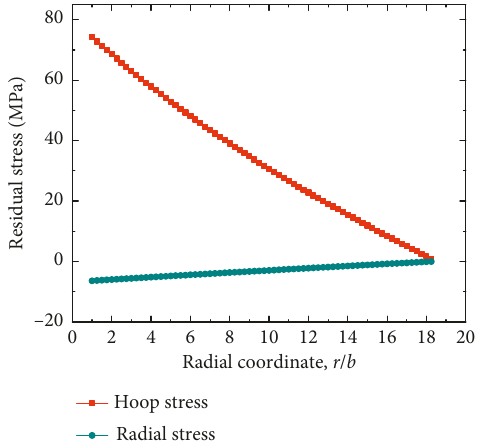
Figure 5: Residual stress distribution of the composite cylinder with an inner